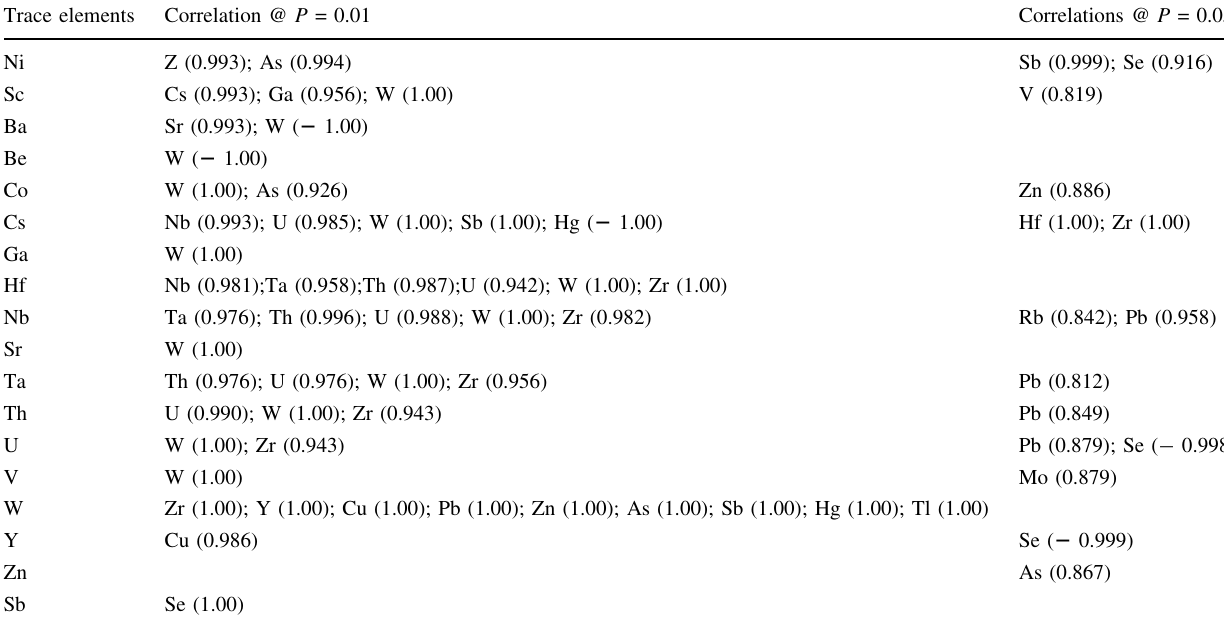
Table 5 Correlationof trace elements in coal Trace